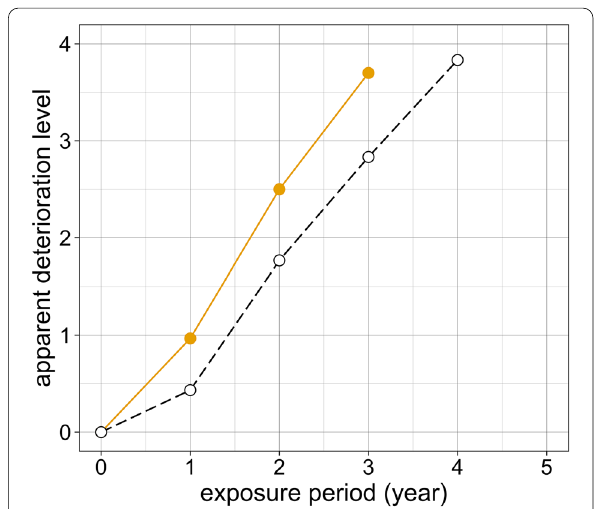
Fig. 3 Plot of deterioration level against exposure period. Closed circle; Ced‑S, open circle; Ced‑H